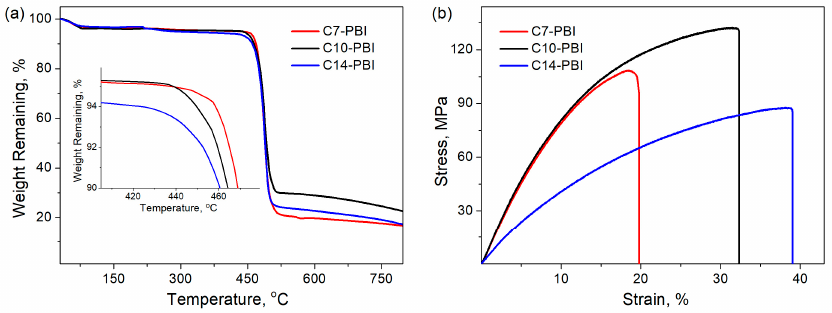
Figure 3. TGA curves ( a ) and stress–strain curves ( b ) of PBIs.